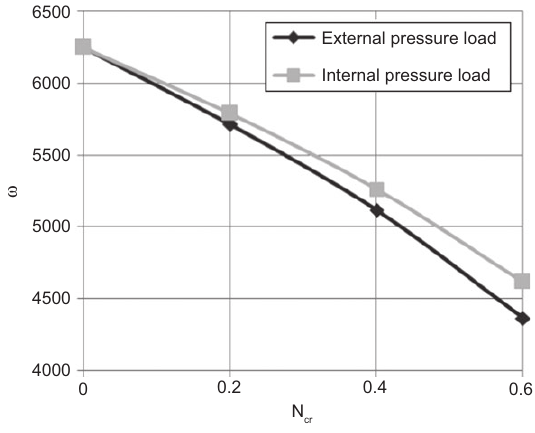
Figure 8 Effect of the different uniform external or internal pressure loads on the fundamental